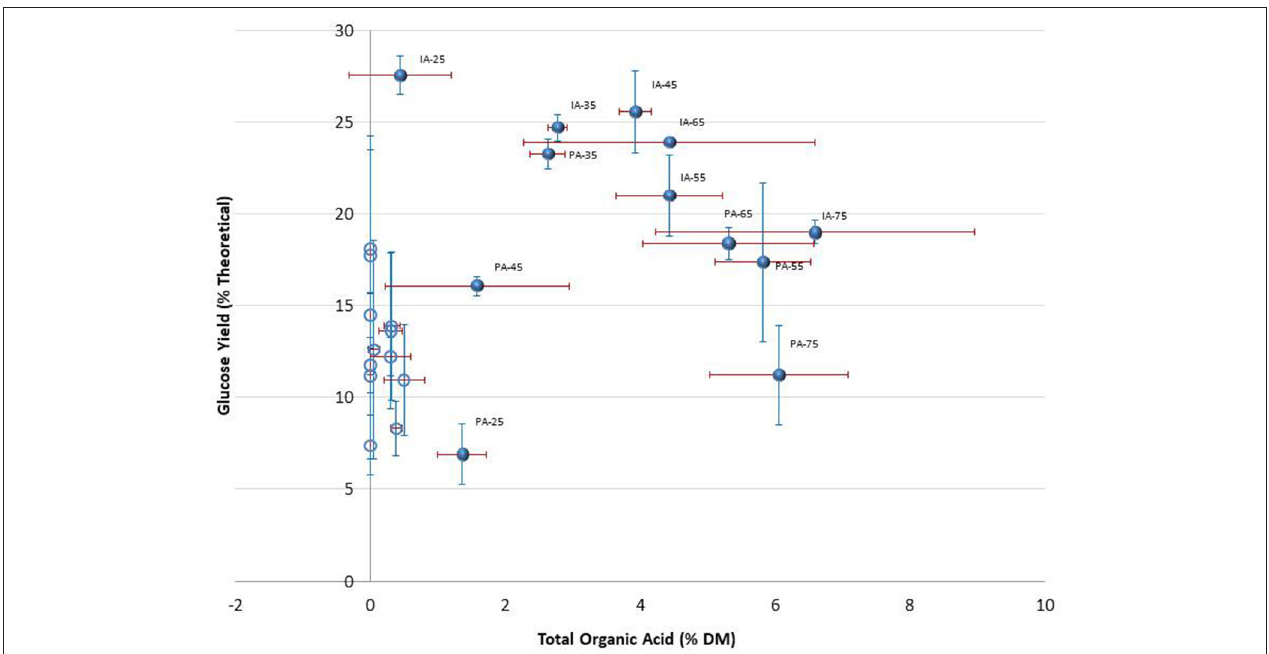
FIGURE 7 | Relationship between total organic acids and glucose yields of PA and IA corn stover without pretreatment. Unlike Figure 6 , this chart is based on actual values of glucose yields (from 15 FPU/g enzyme loadings) and actual amount of organic acids as percentage of dry matter. Filled circles = Day 220; Opened, unlabeled circles = Day 0. Data labels for Day 0 not included because congested. Error bars are standard deviation of